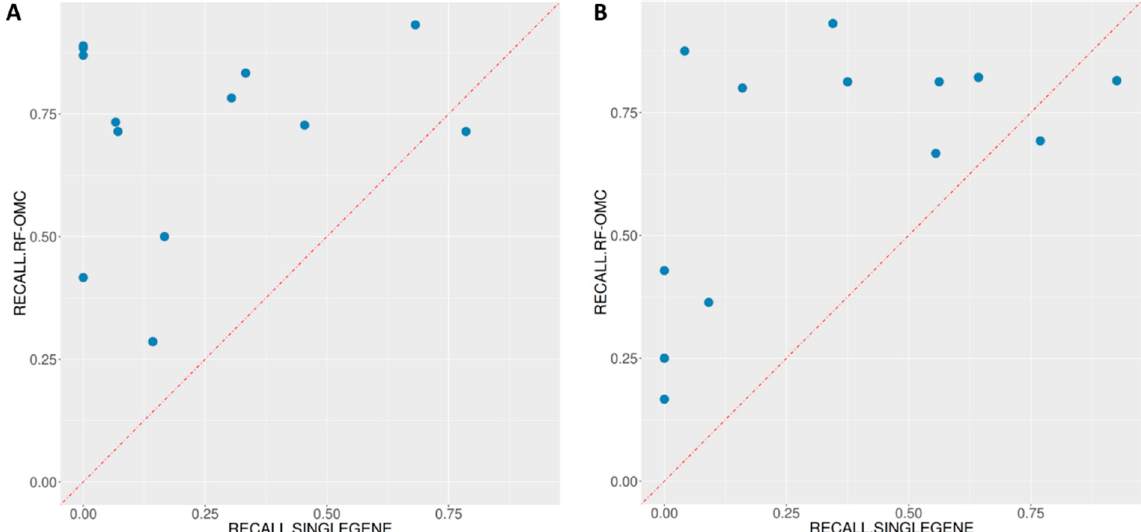
Figure 6. ML multi-gene classifiers exhibit a higher recall than single-gene markers in 23 of the 26 treatment-cancer type pairs. ( A ) In 12 of the 13 treatments for BRCA, multi-gene markers achieve a higher recall than the single-gene marker. The exception was the BGJ398-KIF20B association. ( B ) In 11 of the 13 treatments for CRC, multi-gene markers achieve a higher recall than the single-gene marker. These two single-gene markers with higher recall are the association BYL719-TMEM184A and the association BYL719+LJM716-LSR. Note that these three genes (KIF20B, TMEM184A and LSR) all have very high prevalence (47%, 61% and 85%, respectively) in addition to having the lowest p -value as a sensitive marker in their respective cancer types.